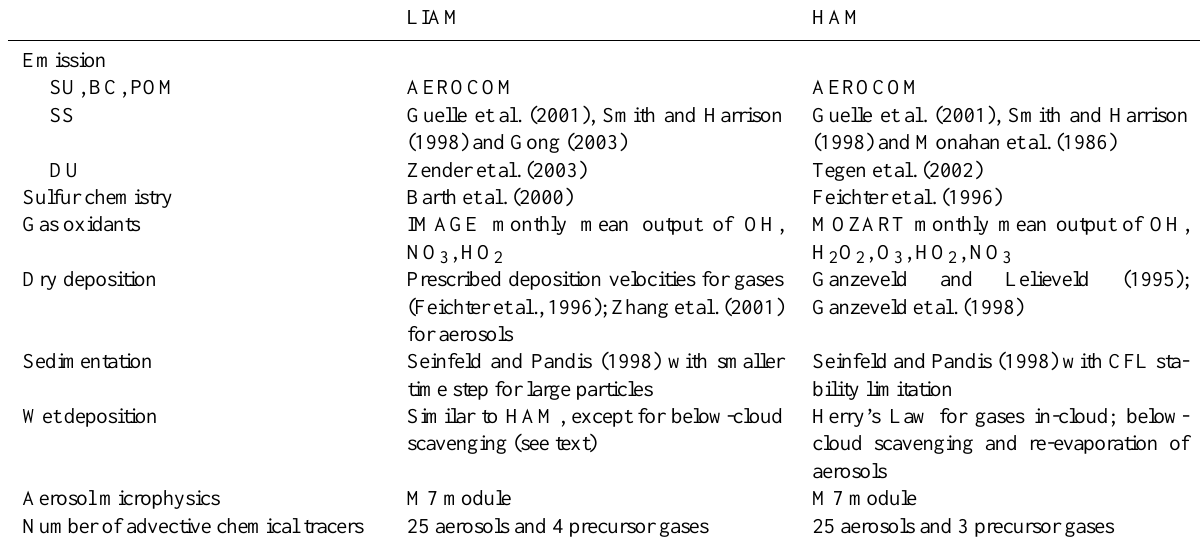
Table 2. Summary of the main components of the two aerosol modules used in this